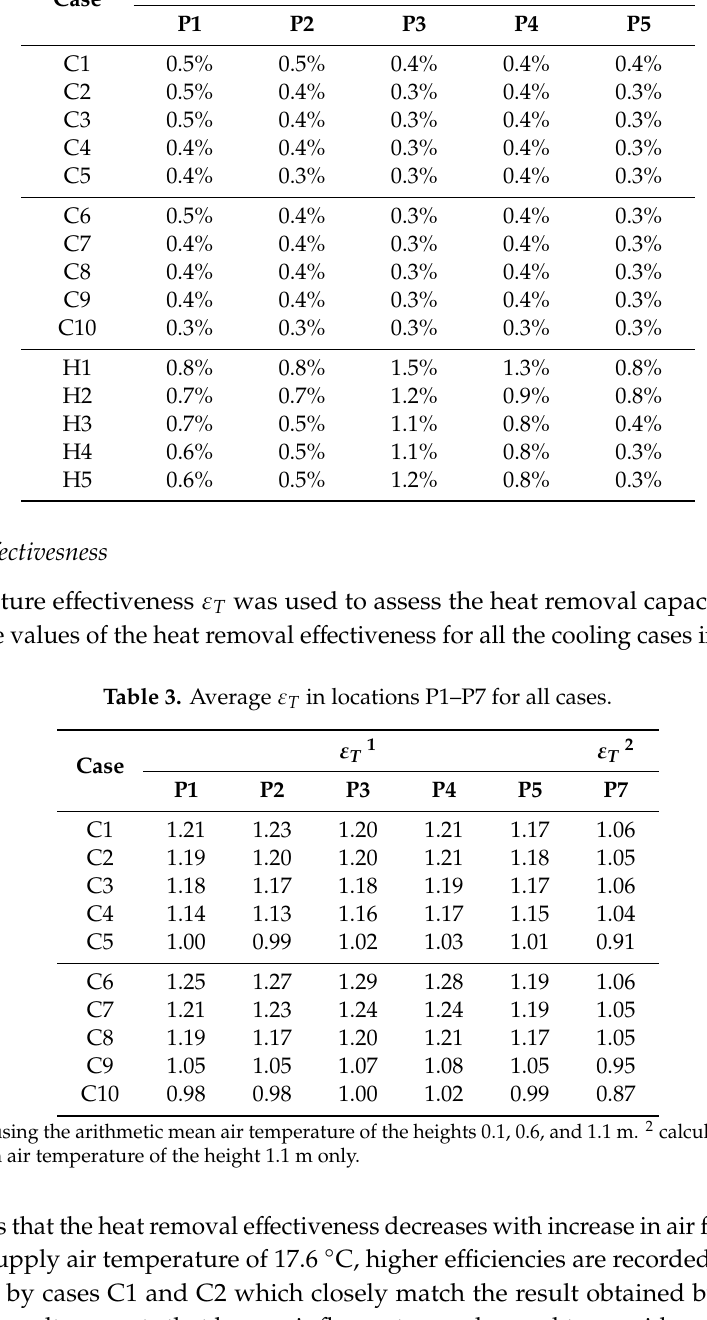
Table 2. Local discomfort (PD) due to high vertical air temperature di ff erence between head and ankle. PD Case P1 P2